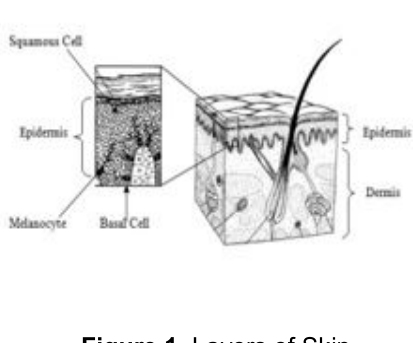
Figure 1. Layers of